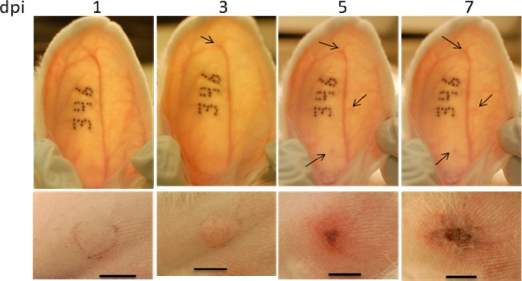
Ears and primary inoculation site of RPV infected NZW rabbits over time. Rabbits were infected as described in Figure 2. The top row of photographs shows the progression of secondary lesions in the ears of RPV infected rabbits. Arrows note the site of secondary lesions. The bottom row of photographs shows the progression of the primary lesions over time. Bars represent 1 cm.